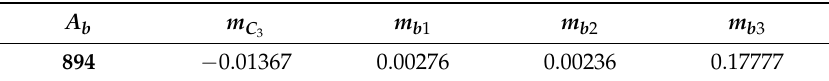
Table 3. Model coefficients of HS b function.